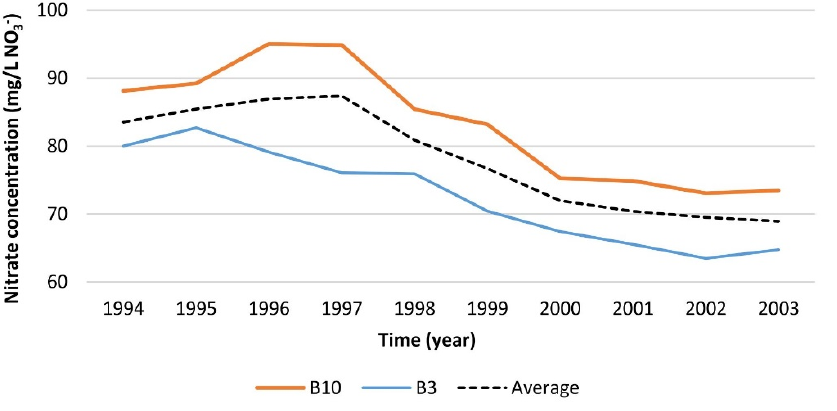
Figure 3. Time series of nitrate concentration annual averages in groundwater at the Varaždin well- field.